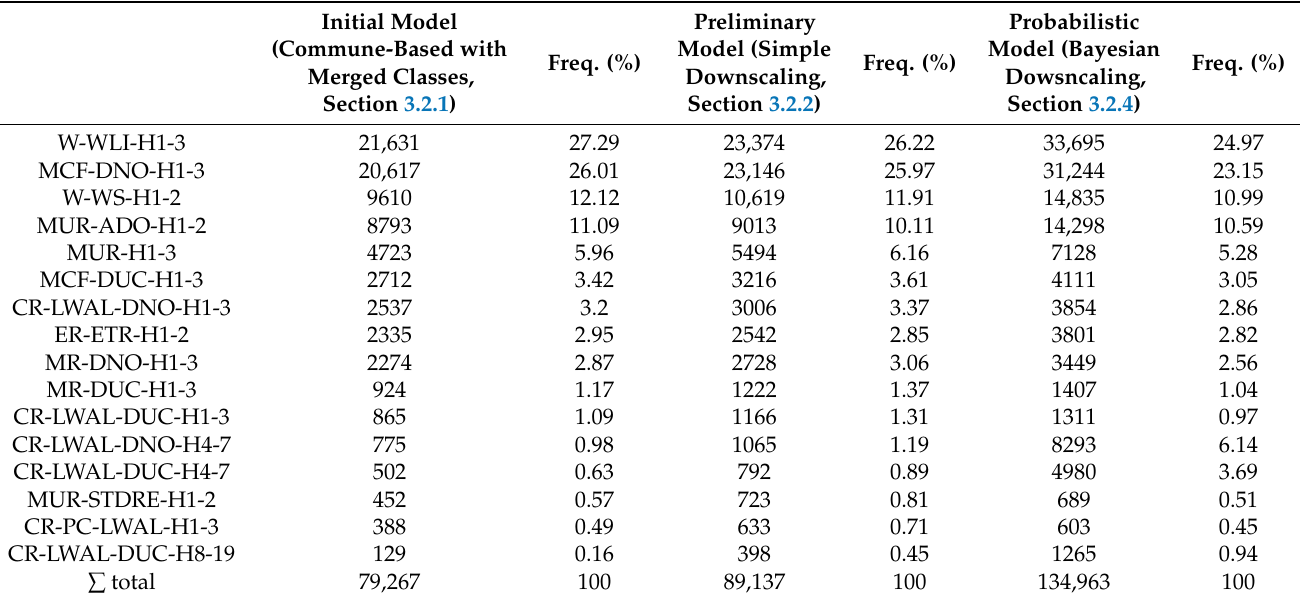
Table 3. Comparison between the counts and frequencies for each building typology of the three considered exposure